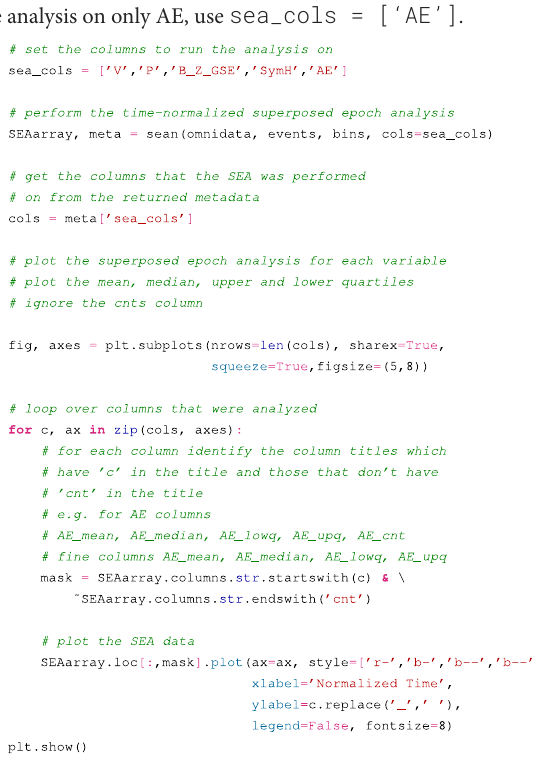
, Sym-H and AE. It is clear that z